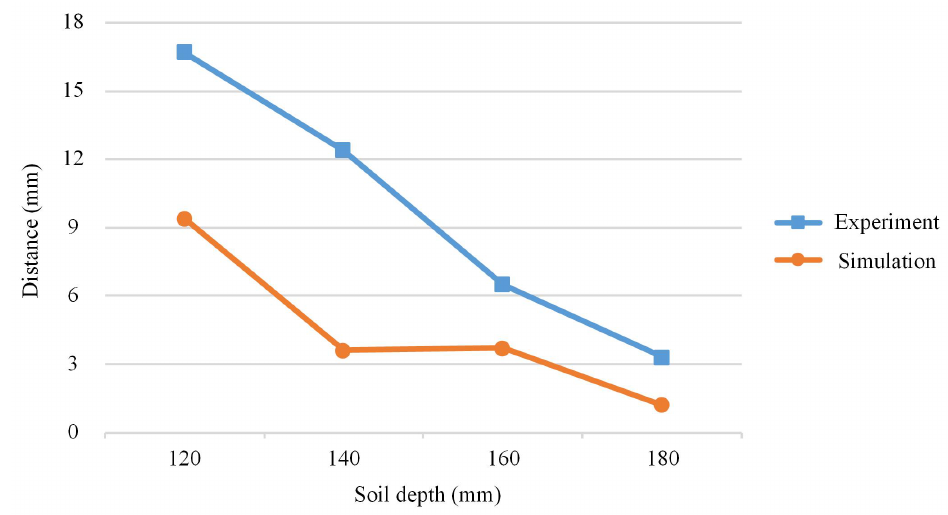
Figure 11. Comparison of simulation results and experiment results at different soil depths at 1 m/s.